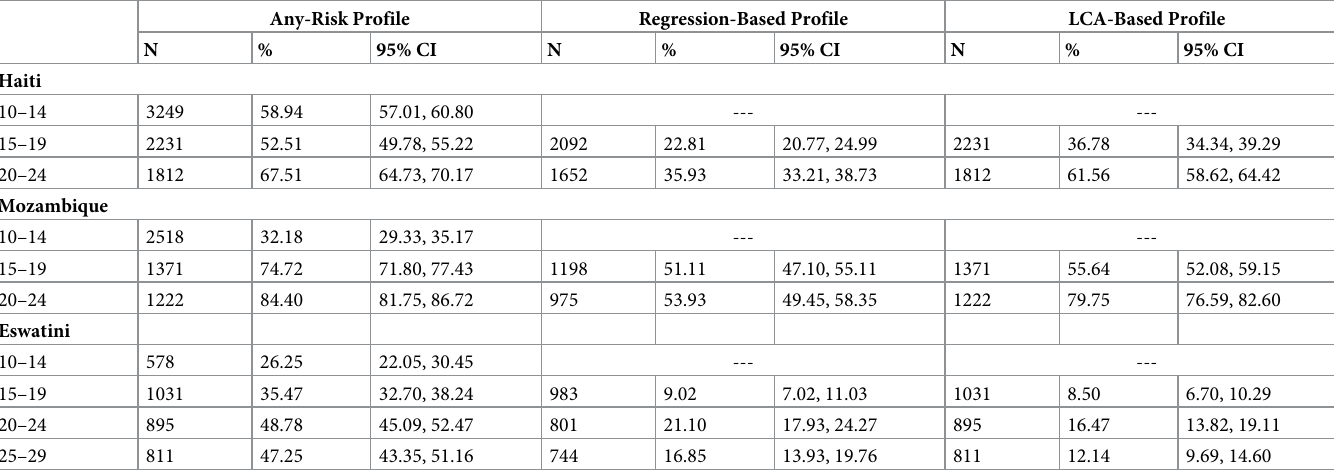
Table 6. Percentage of AGYW who are classified as at risk and HIV-negative, by method. Any-Risk Profile Regression-Based Profile LCA-Based